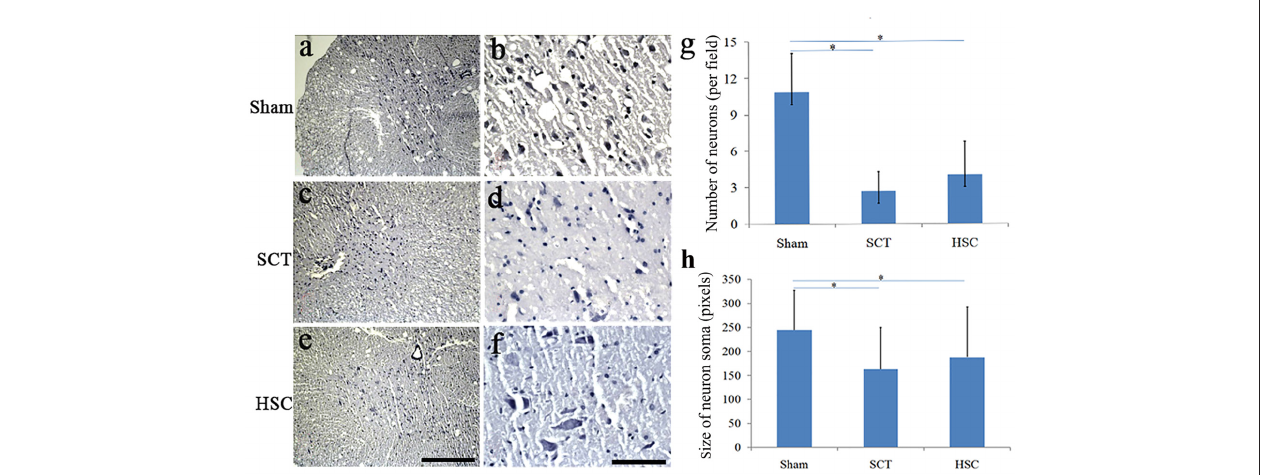
FIGURE 7 | The effect of HSC transplantation on the neural survival. Compared with the sham group (A,B,G,H) , the number and size of neurons in ventral horn in the SCT group (C,D,G,H) became markedly less. However, quantitative analysis showed no differences on the number and size of neurons between SCT and HSC groups, P > 0.05 (E–H) . Data are presented as the mean ± SD ( n = 7). One-way ANOVA was used to analyze the data. ∗ P < 0.05 vs. sham. Bar = 100 µ m in (A,C,E) ; 50 µ m in (B,D,F) .